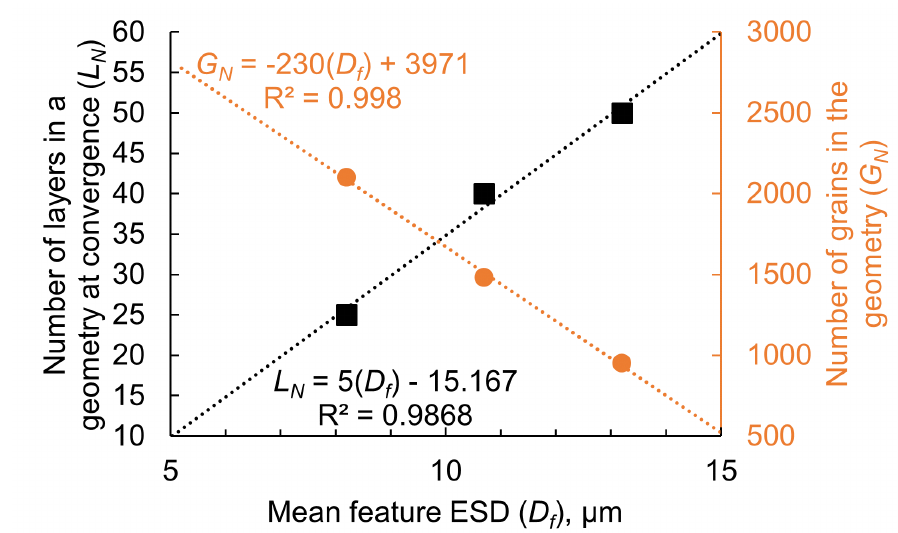
Figure 10. Constructed empirical convergence criteria from results of RVE-A, B and C converged simulations, where black trend line represented the function between mean feature ESD and required number of layers for converged solution. Orange trend line represents the relationship between mean feature ESD and number of grains that can be packed in a 100 × 100 × 100 µ m 3